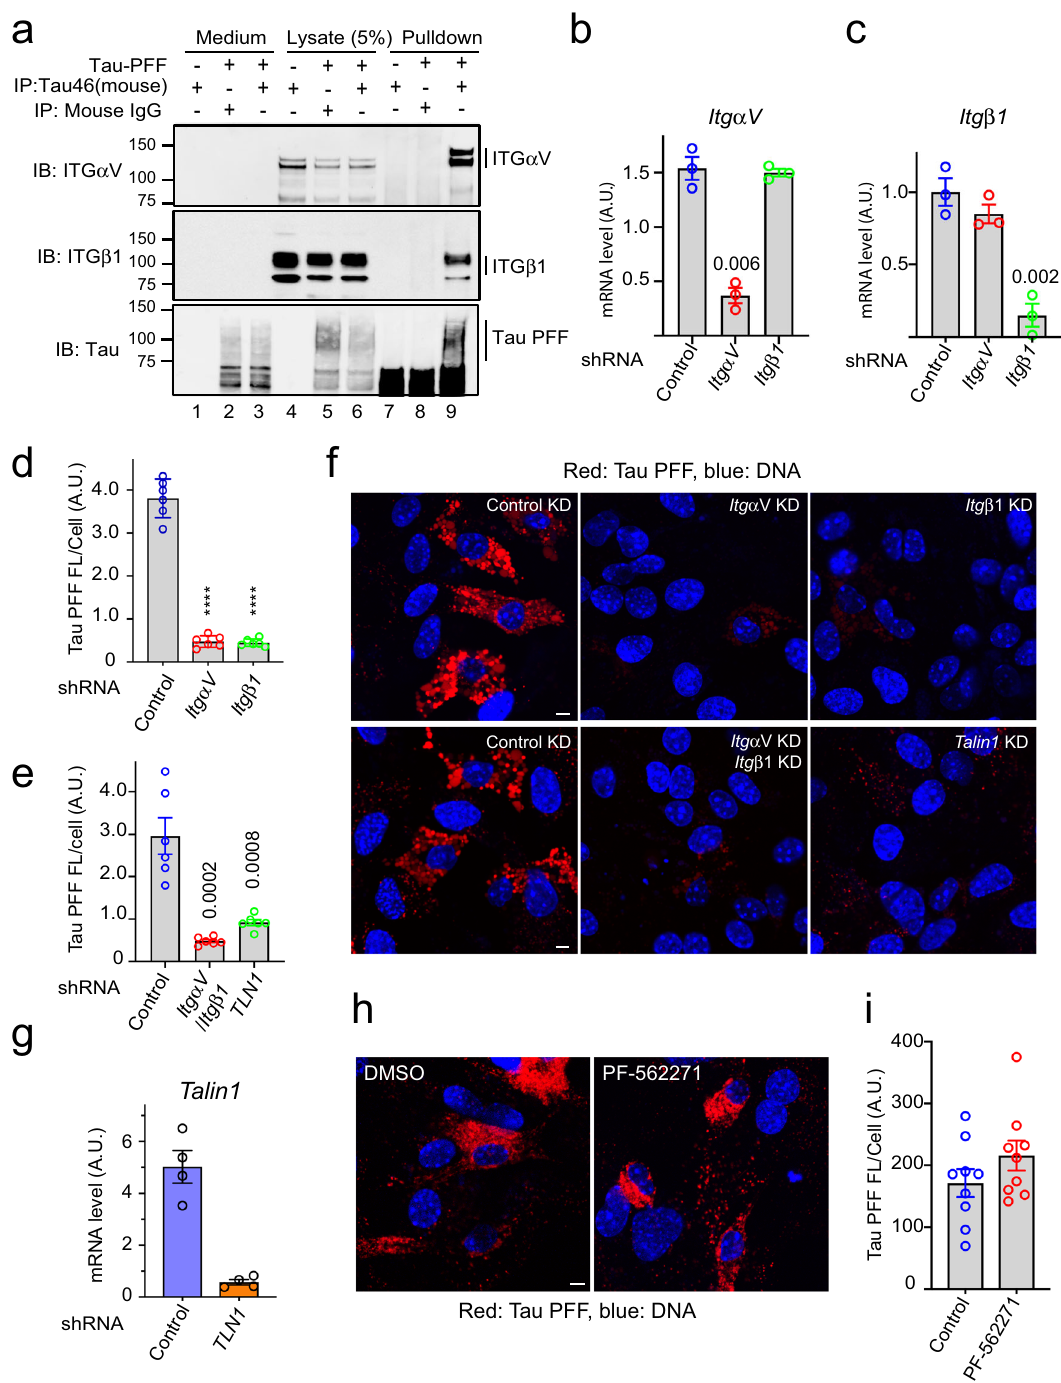
Red: Tau PFF, blue: